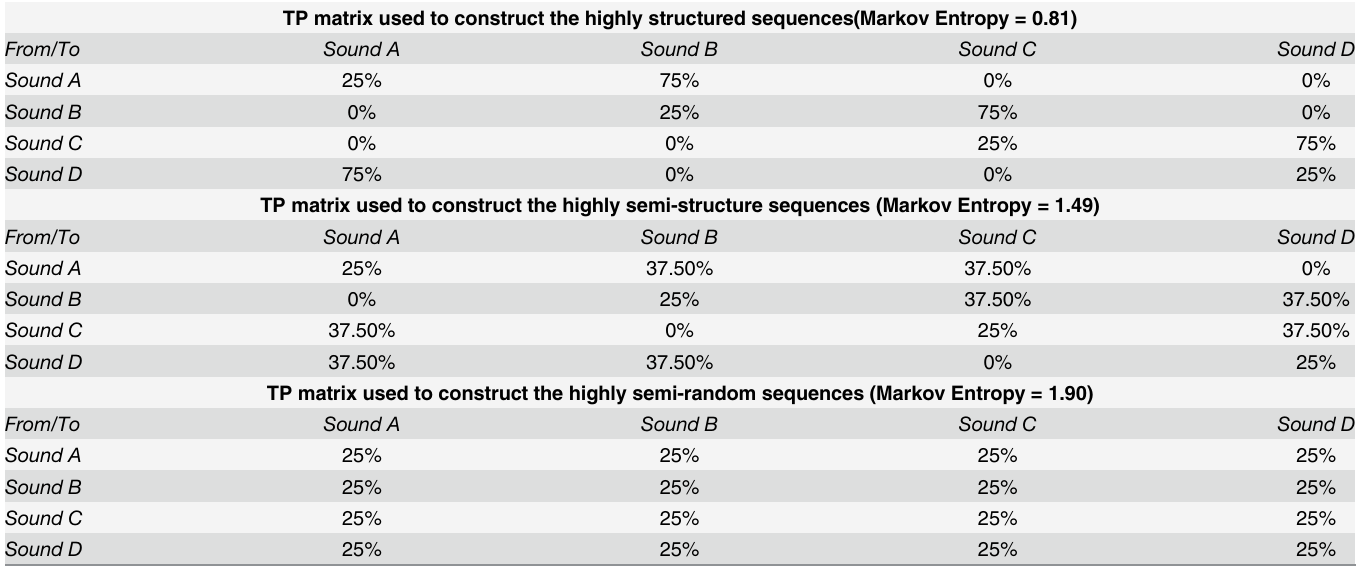
Table 1. Transition probability matrix for the 3 levels of regularity. TP matrix used to construct the highly structured sequences(Markov Entropy = 0.81) From/To